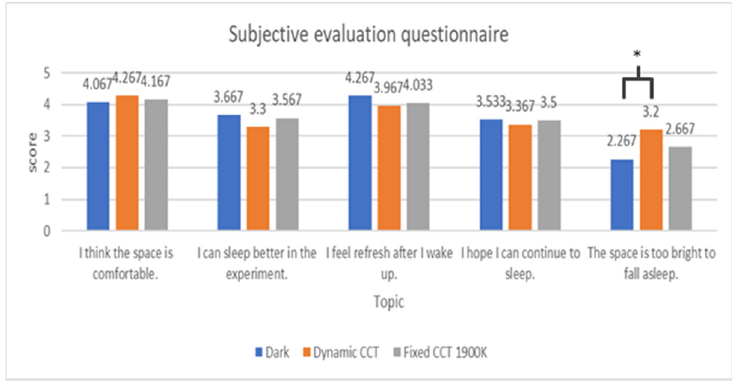
Figure 16. Subjective questionnaire (* p < 0.05).